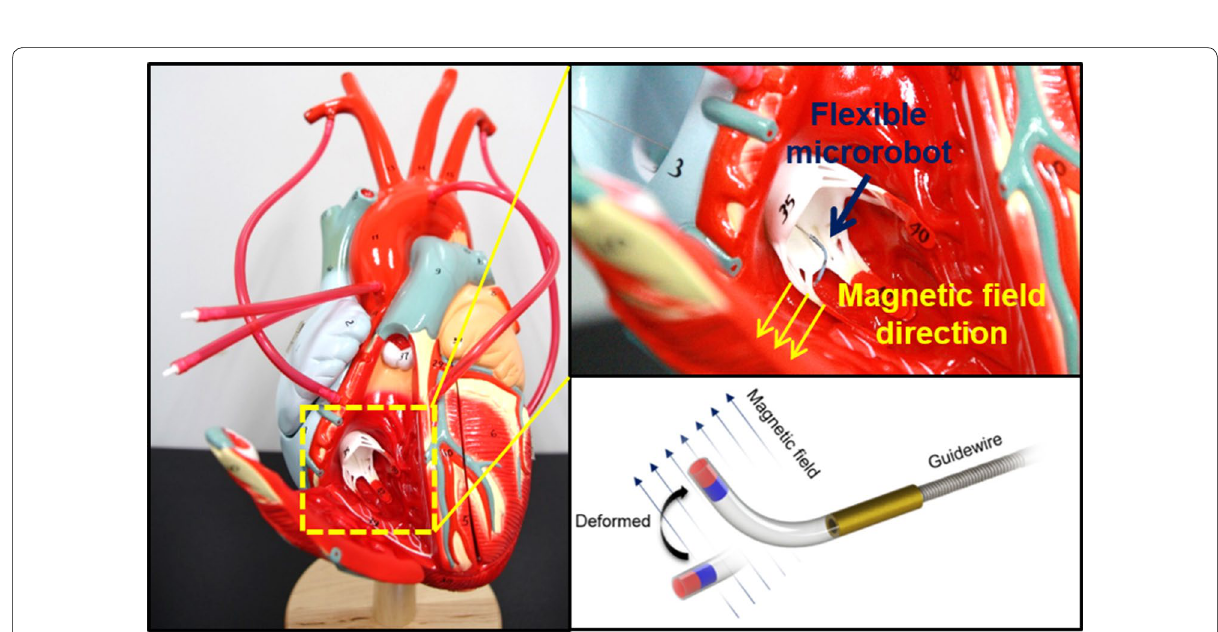
Fig. 1 Schematic of the magnetically actuated flexible microrobot used to improve guidewire